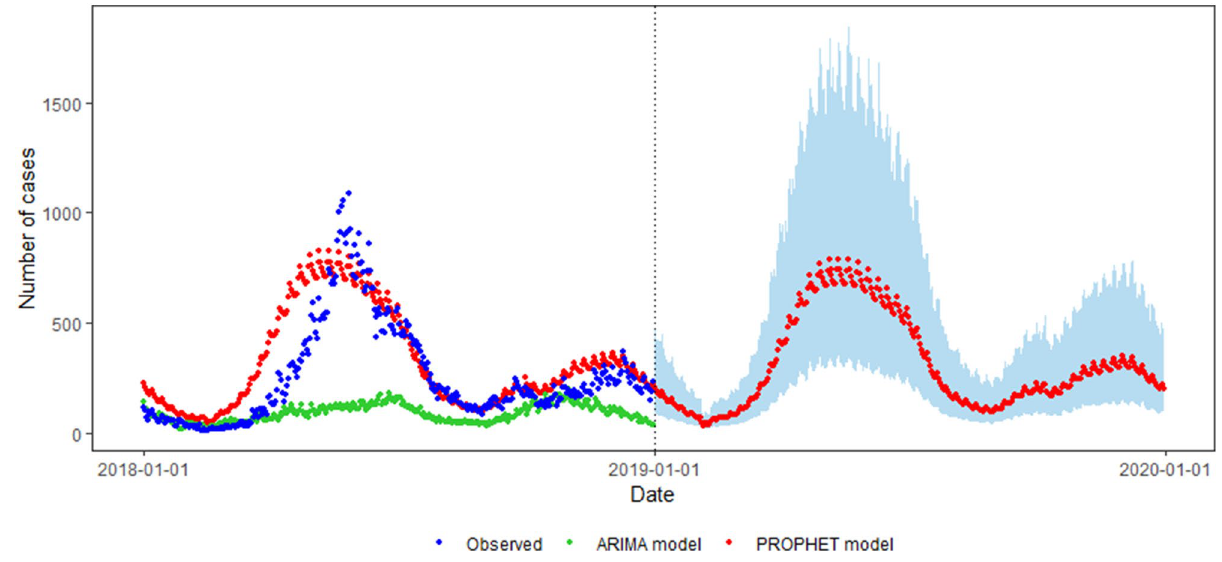
Figure 3. Visualization of fitting for both models in 2018 and forecast of HFMD using the Prophet model in 2019.